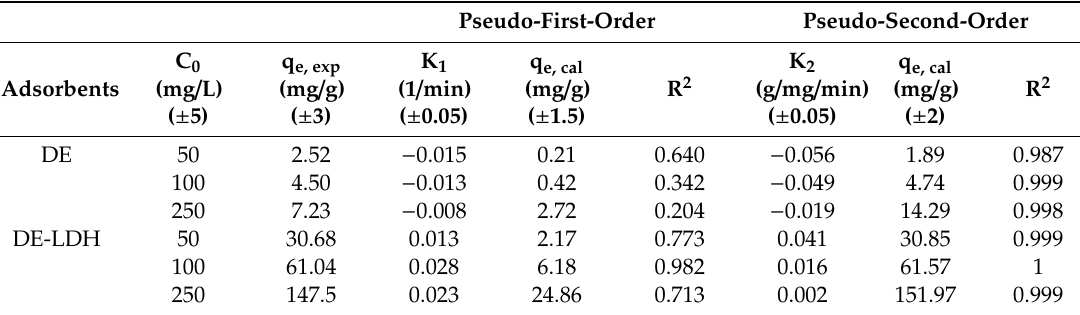
Table 3. Adsorption kinetic values for adsorption of CR onto DE and DE-LDH.